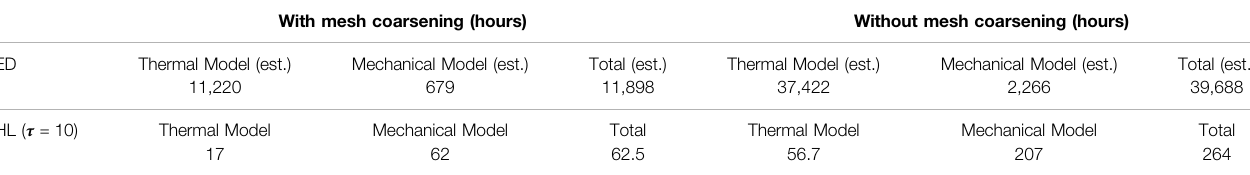
TABLE 3 | Computional time (hours) comparison between the ED beam-scale and HL ( τ (cid:2) 10) part-scale models with and without the mesh coarsening technique.